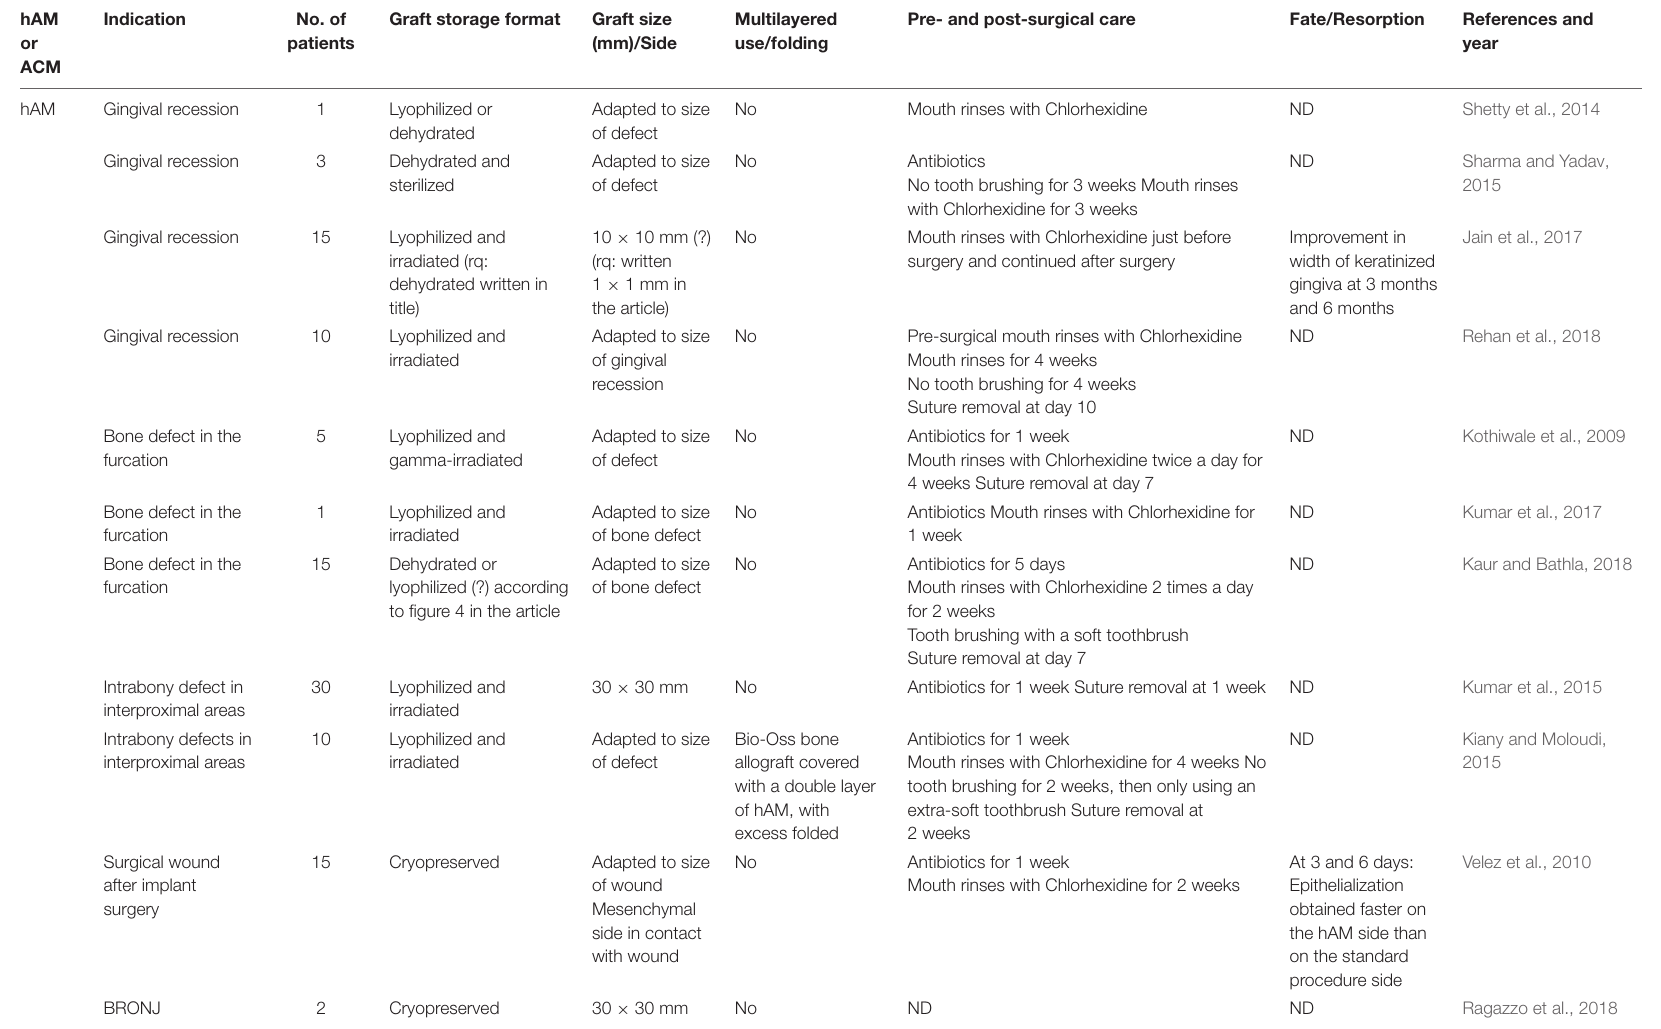
TABLE 1 | hAM and ACM used as an implanted membrane. hAM